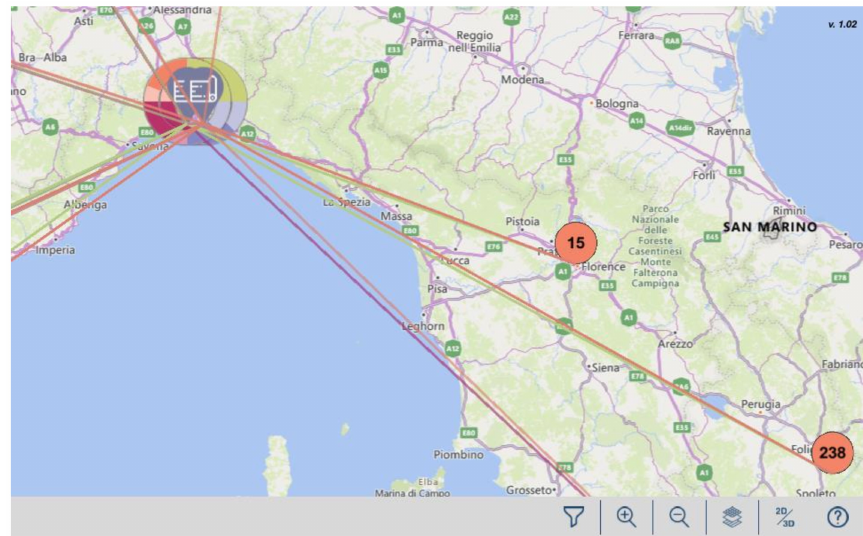
Figure 7. Line-based representation of the relationship between the properties of the objects in SILKNOW.